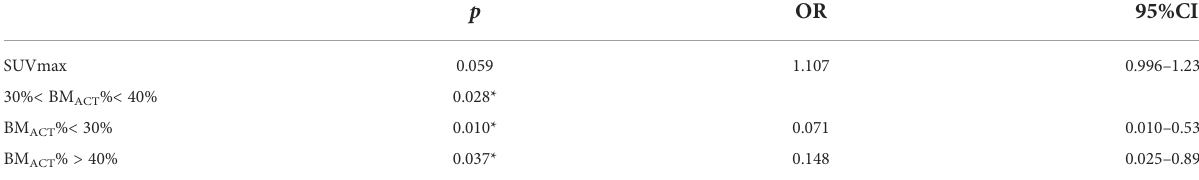
TABLE 4 Logistic regression